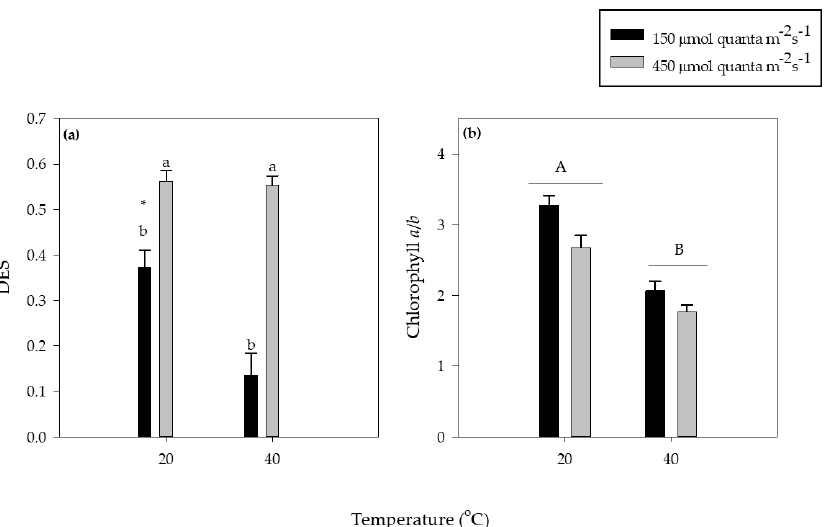
Figure 3. Effects of temperature and light on Cymodocea nodosa : ( a ) De-epoxidation ratio (DES) and ( b ) chlorophyll a to chlorophyll b ratio (Chlorophyll a / b ). Values represent mean ± SE ( n = 3). Different letters indicate significant differences among light levels under the same temperature ( p < 0.05, SNK test); * indicate significant differences among temperatures under the same light level ( p < 0.05, SNK test); capital letters indicate differences among temperature independently of light level (no interaction among factors; p < 0.05, SNK test).